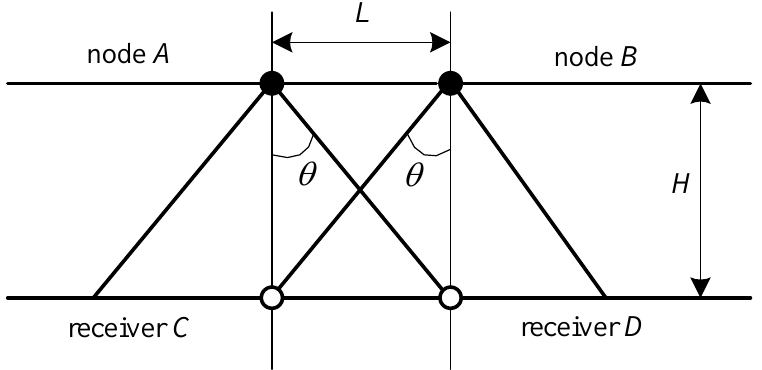
Figure 2. The side view of the node